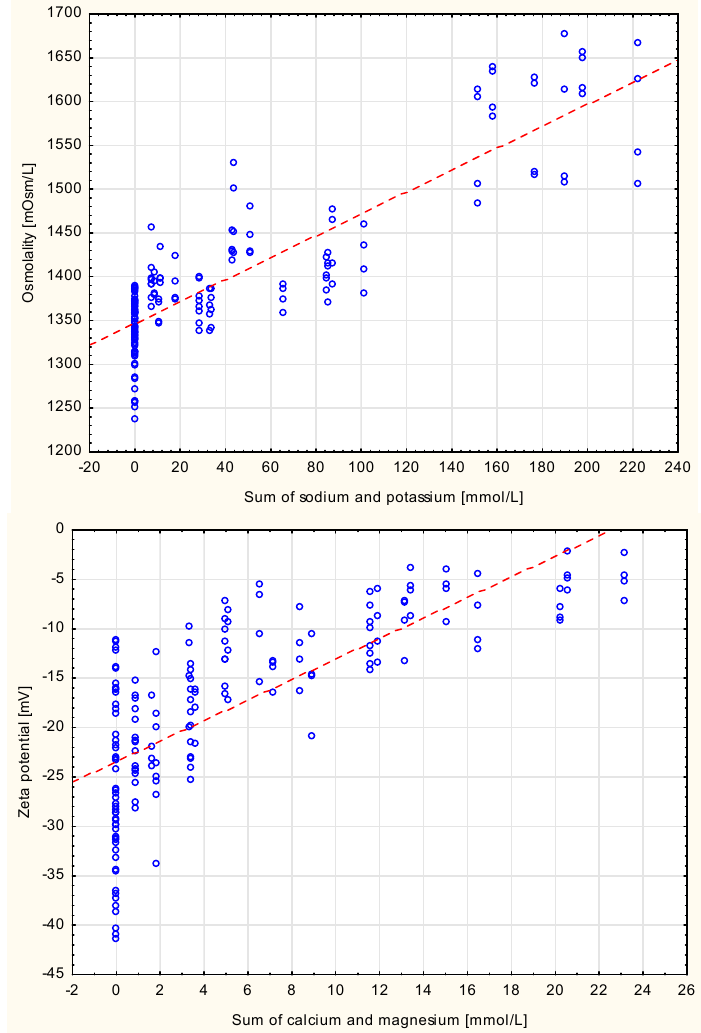
Figure 4. Correlation between selected physicochemical properties and ingredients of PN admix- ture.